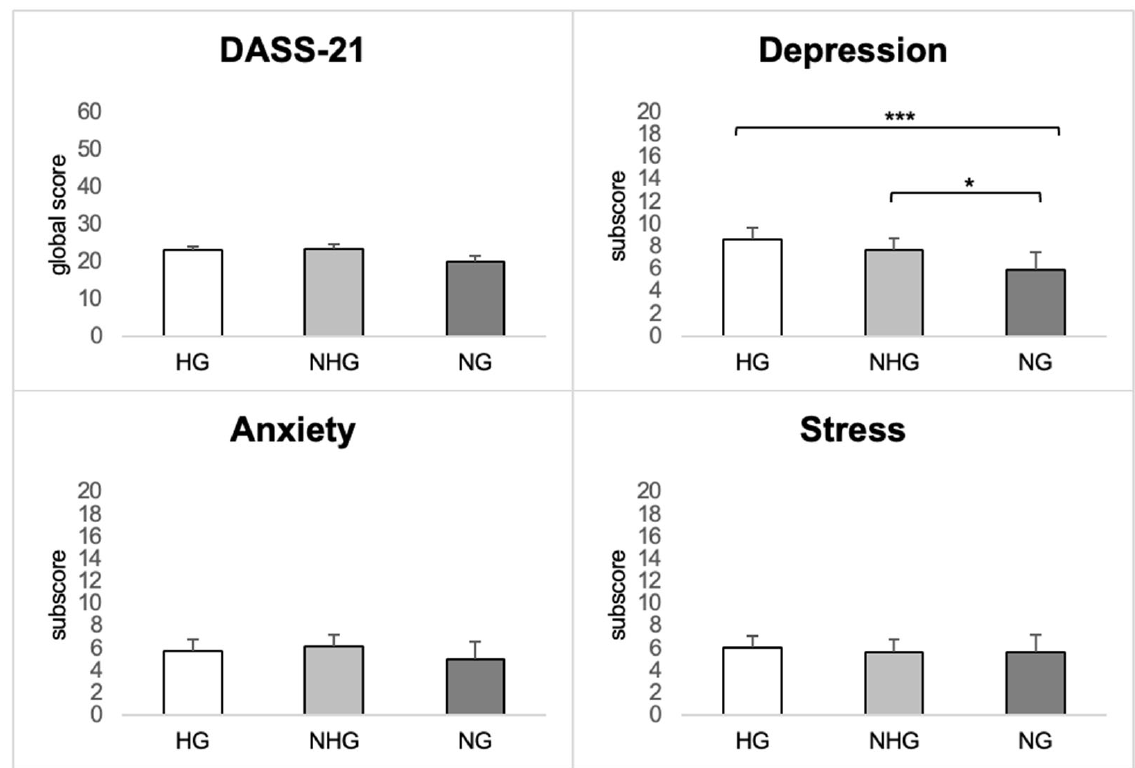
Figure 1. DASS ‐ 21 global score and DASS ‐ 21 subscores in the three groups. *** p < 0.001; * p < 0.05. Figure 1. DASS-21 global score and DASS-21 subscores in the three groups. *** p < 0.001; * p < 3.3. Regression Analyses with Hours Spent VG Playing or VG Stream ‐ Watching as Predictors